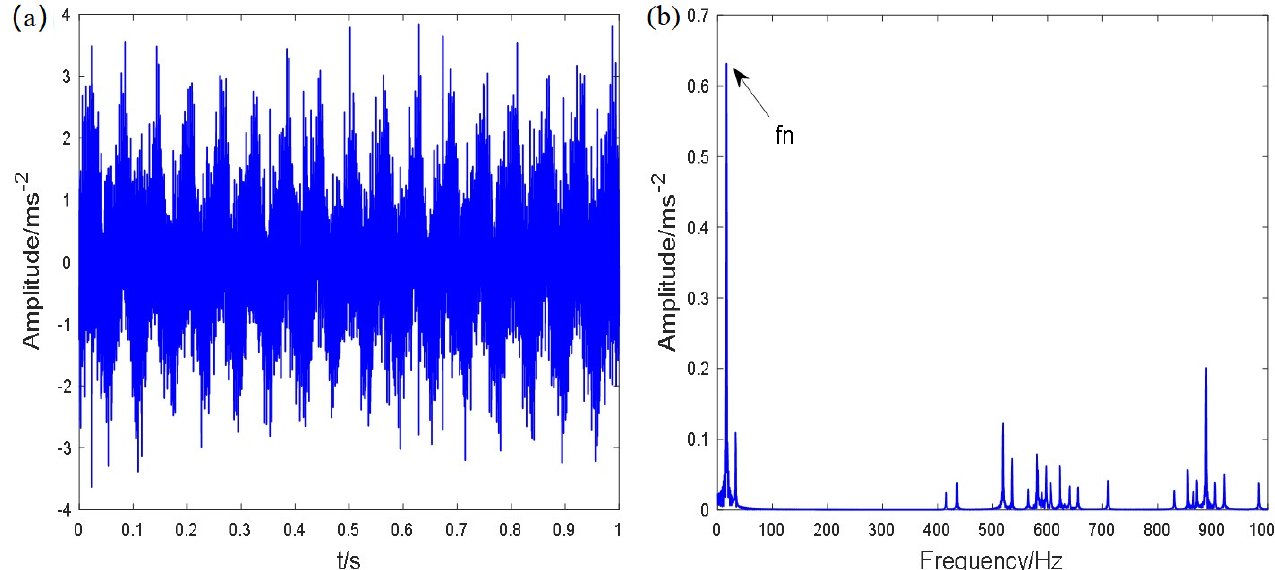
Figure 7. The flow chart of the method of combining SSVD and RWOA-VMD for signal processing of vibrating screen exciter bearing.